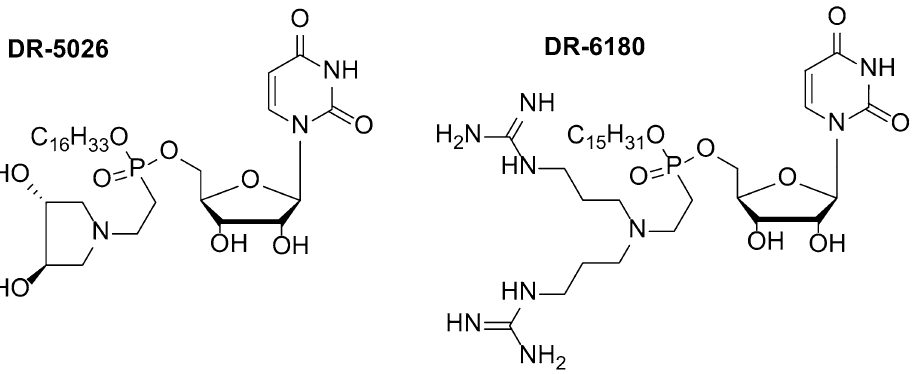
Figure 1. Selected examples of first- (DR-5026) and second-generation (DR-6180) LPPOs used in this